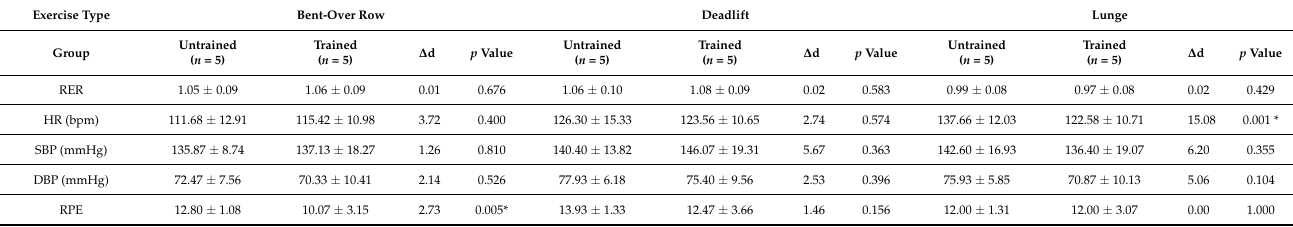
Table 2. Physiological parameters during three weight training sessions ( n = 10).